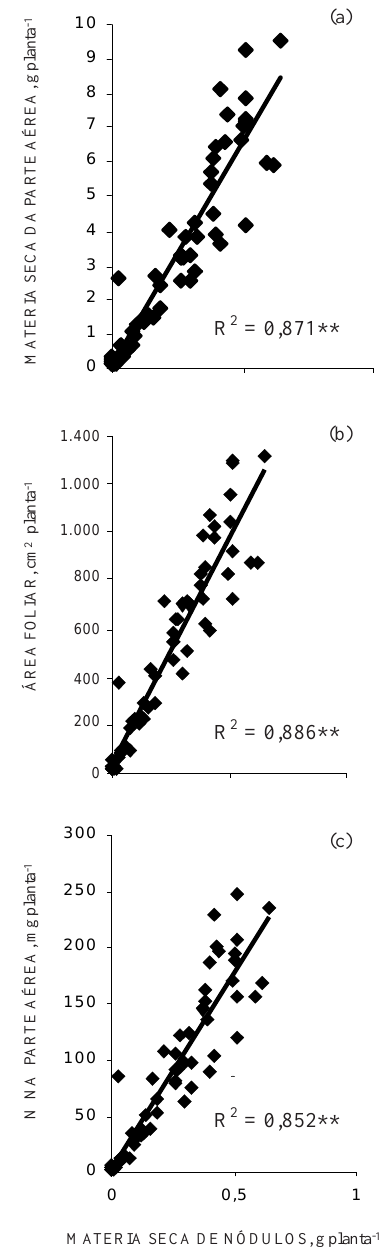
Figura 1. Correlações entre a matéria seca de nódulos por planta e as variáveis matéria seca de parte aérea (a), área foliar (b) e N acumulado na parte aérea (c) de plantas de guandu, submetidas à inoculação com diferentes rizóbios nativos dos tabuleiros costeiros. Os dados dos tratamentos sem inoculação não foram